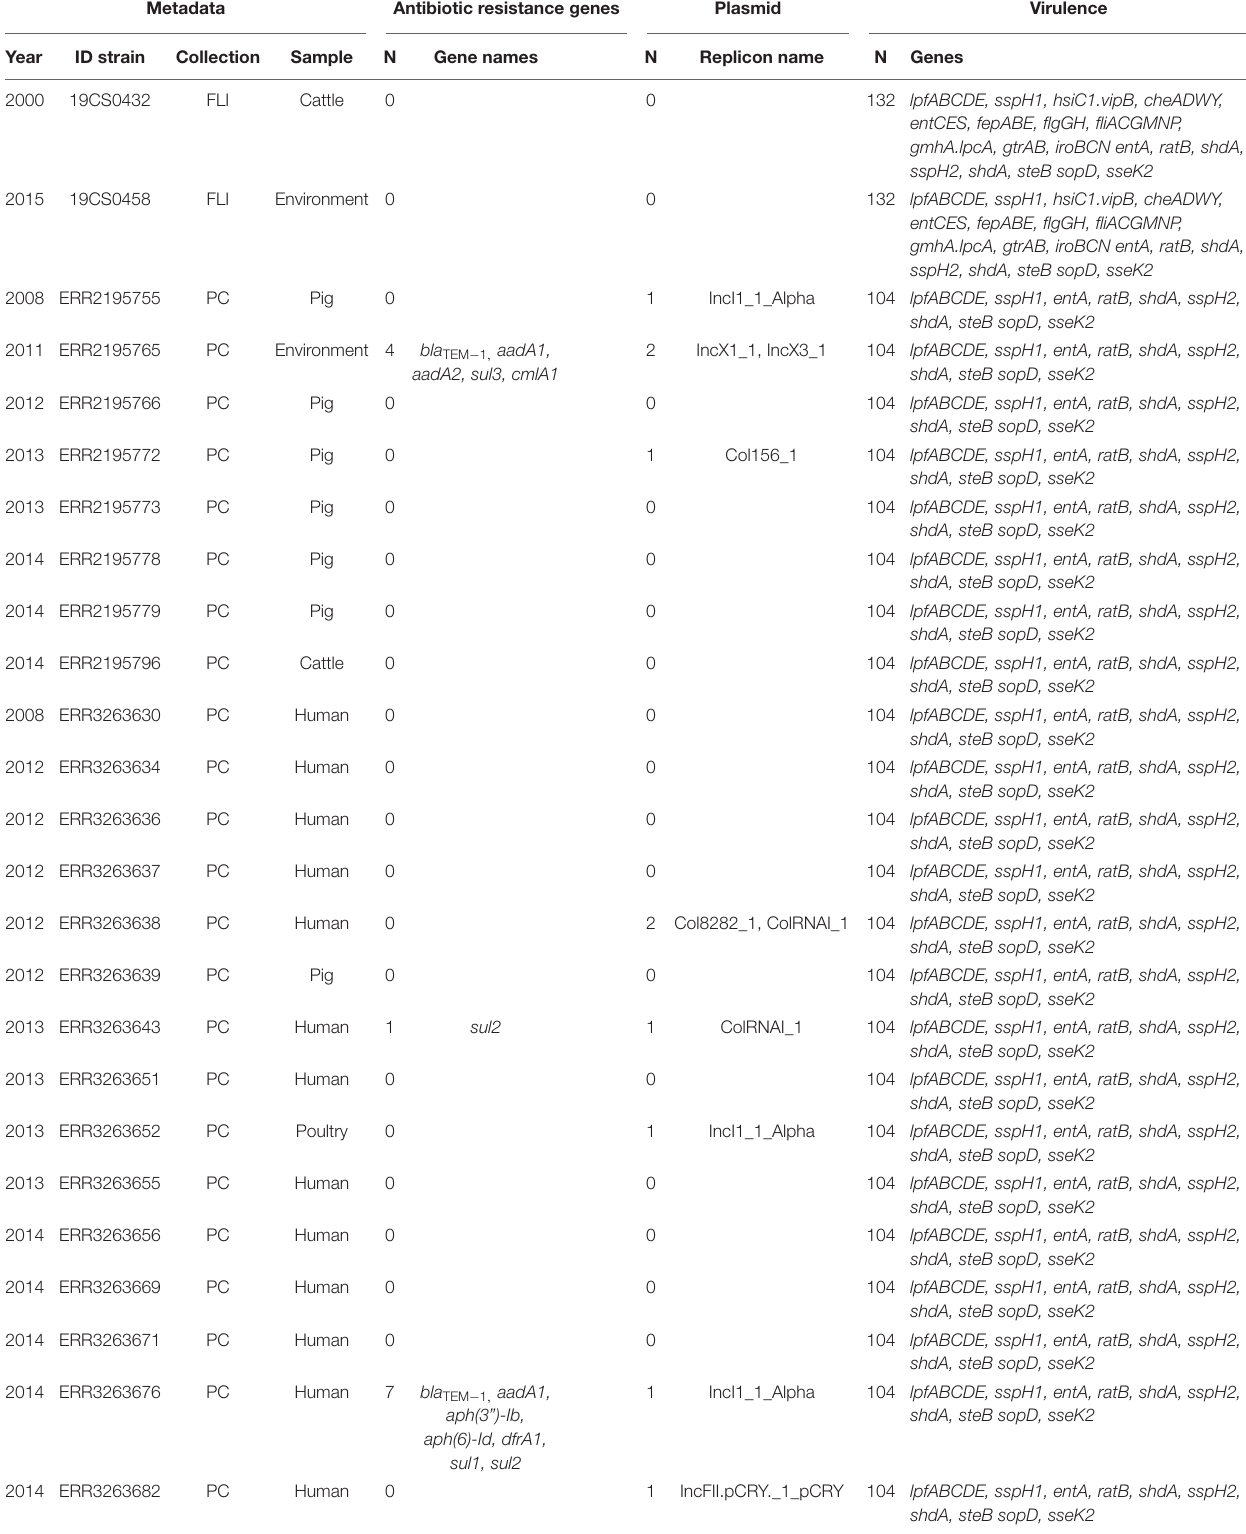
TABLE 4 | ST682 genome information about the antimicrobial resistance genes, plasmid replicons and virulence genes, n = 25. Metadata Antibiotic resistance genes